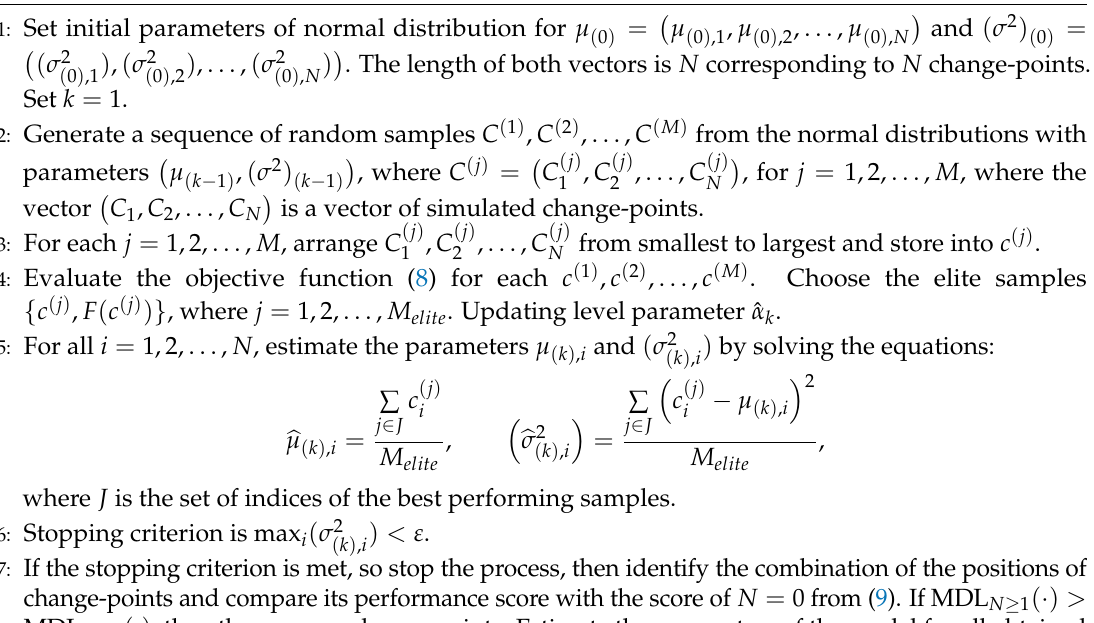
Algorithm 2 The CE.AR